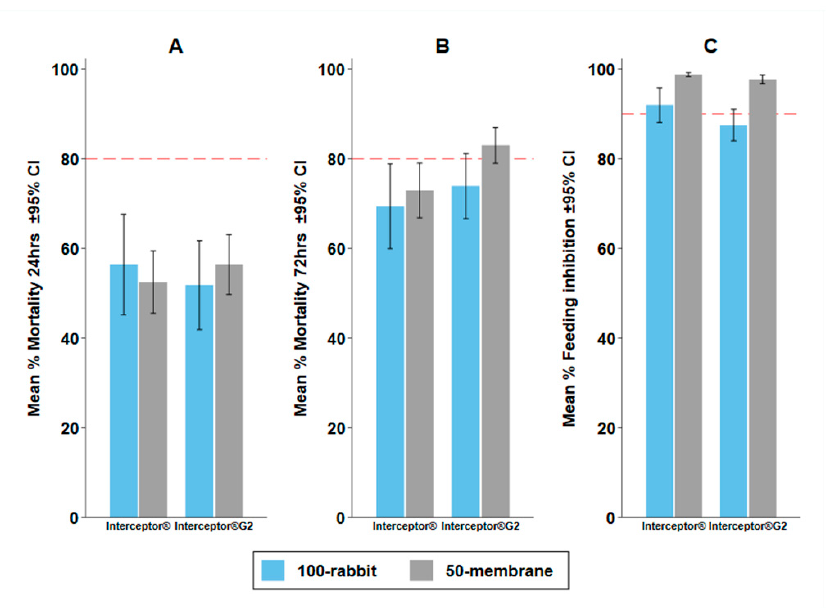
Figure 7. Mean percentage mortality and 95% confidence interval (CI) for ( A ) 24-h (M24); ( B ) 72-h (M72); and ( C ) blood feeding inhibition (BFI) for Interceptor ® and Interceptor ® G2 nets against pyrethroid-resistant Anopheles arabiensis with 100-rabbit (rabbit bait and density of 100 mosquitoes) and 50-membrane (Hemotek ® membrane bait and density of 50 mosquitoes) in the WHO tunnel test. The red dashed line depicts the WHO minimum bio-efficacy thresholds of ≥ 80% M24 and ≥ 95% BFI.